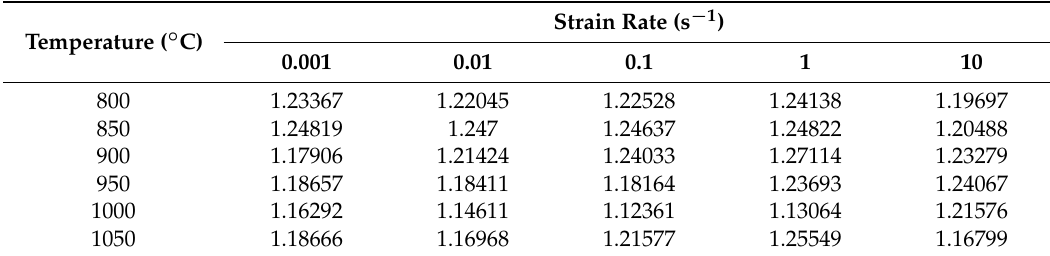
Table 1. The values of B under different deformation conditions.